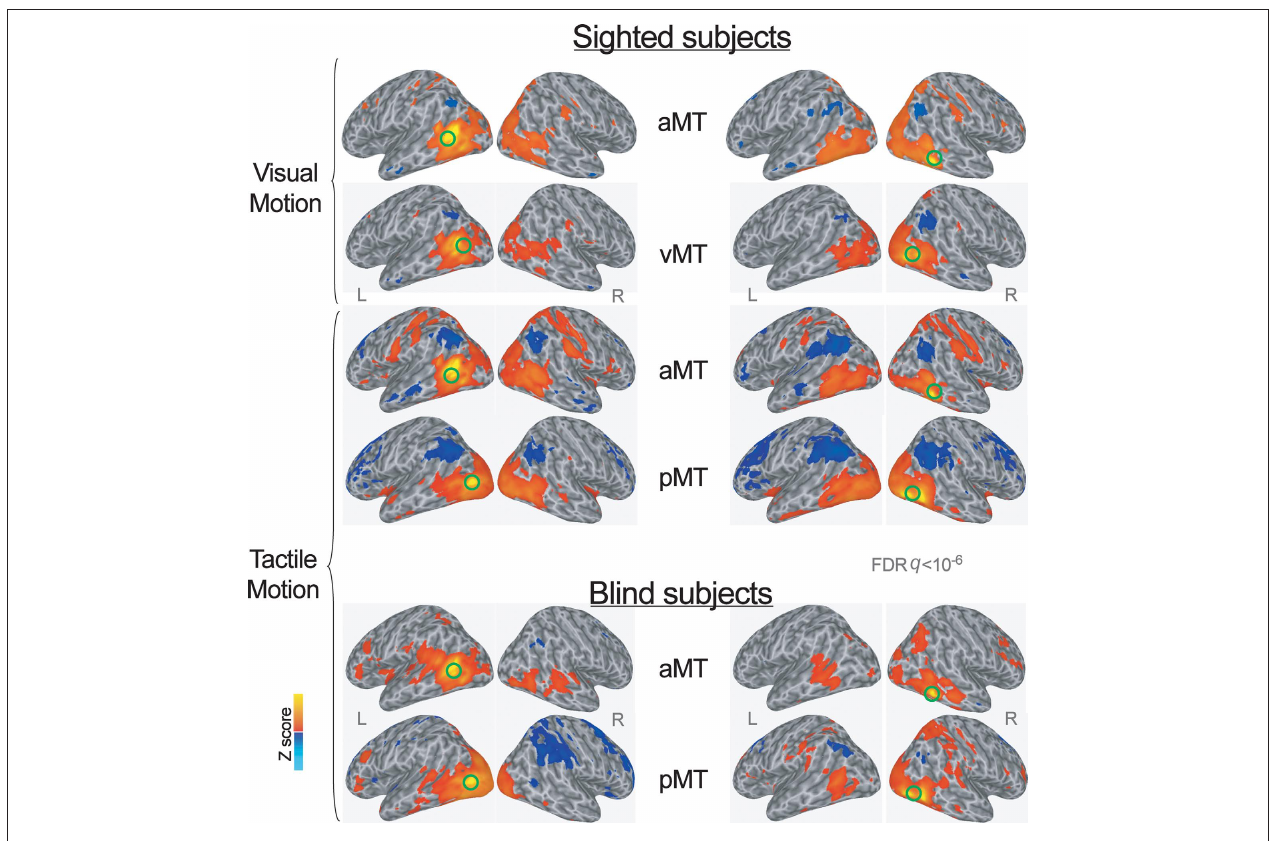
Spatially normalized activations are projected onto a single-subject cortical surface template in the Talairach–Tournoux standard space. Lateral views of the inflated right and left hemispheres are shown. Green circles identify the seed-ROIs used for the functional connectivity correlation